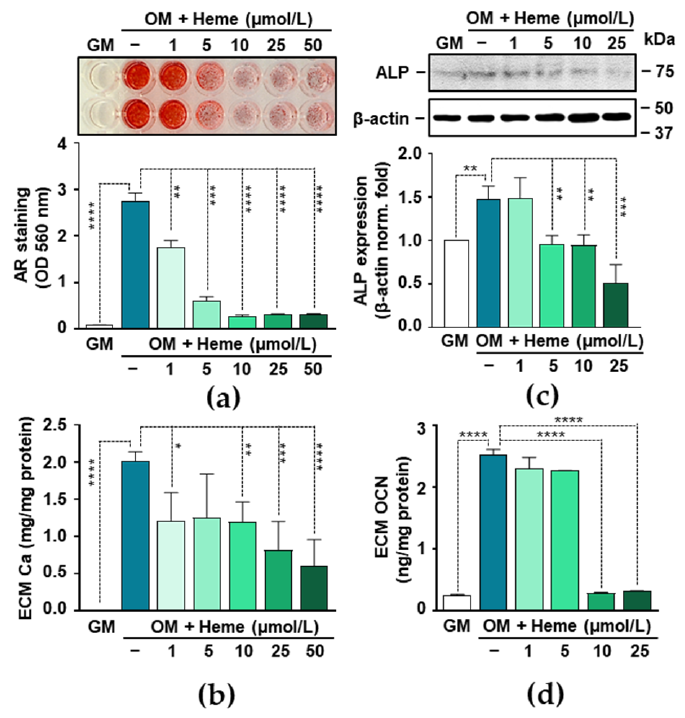
Figure 2. Heme inhibits OM-induced calcification of VICs in a dose-dependent manner. ( a – d ) Con- fluent VICs (passage number 5–8) were maintained in GM or OM (2.5 mmol/L P and 0.3 mmol/L Ca) in the absence or presence of heme (1–50 µ mol/L). ( a ) Representative AR staining and quantification (day 5) are shown from three independent experiments. ( b ) Ca content of the HCl-solubilized ECM is presented (day 5). Data are expressed as mean ± SD of three independent experiments performed in triplicate. ( c ) Protein expression of ALP was determined from whole cell lysates (72 h). Membranes were reprobed for β -actin. Representative Western blots and relative expression of ALP normalized to β -actin from three independent experiments are shown. Data are expressed as mean ± SD. ( d ) OCN levels were determined in EDTA-solubilized ECM samples by ELISA (day 5). Results are presented as mean ± SD of three independent experiments performed in duplicate. * p < 0.05, ** p < 0.01, *** p < 0.005, **** p < 0.001. Osteogenic stimulation triggers the trans-differentiation of VICs to osteoblast-like cells. This process can be monitored by the detection of certain osteoblast-specific proteins including ALP and OCN. Therefore, next we investigated the effect of heme on the expres- sion of these markers. Osteogenic stimulation with OM triggered an about 1.5-fold increase in the expression of ALP as compared to control VICs (GM) (Figure 2c). This increase was blunted in the presence of heme at the concentration of 5, 10, and 25 µ mol/L (Figure